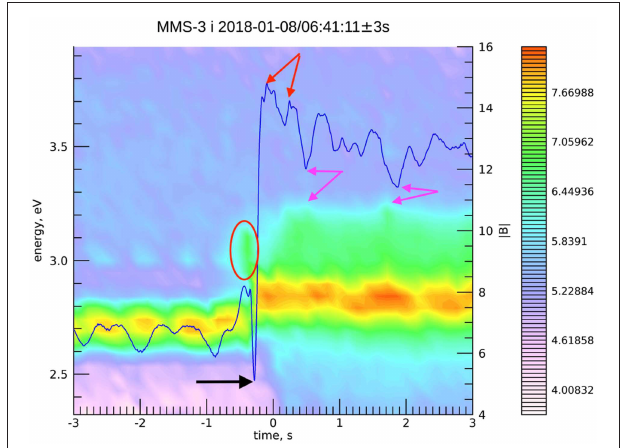
FIGURE 1 | Quasi-perpendicular shock crossing by MMS-3 at 2018-01-08/06:41:11. The magnetic profile is shown in the background of the ion spectrogram (log of energy).